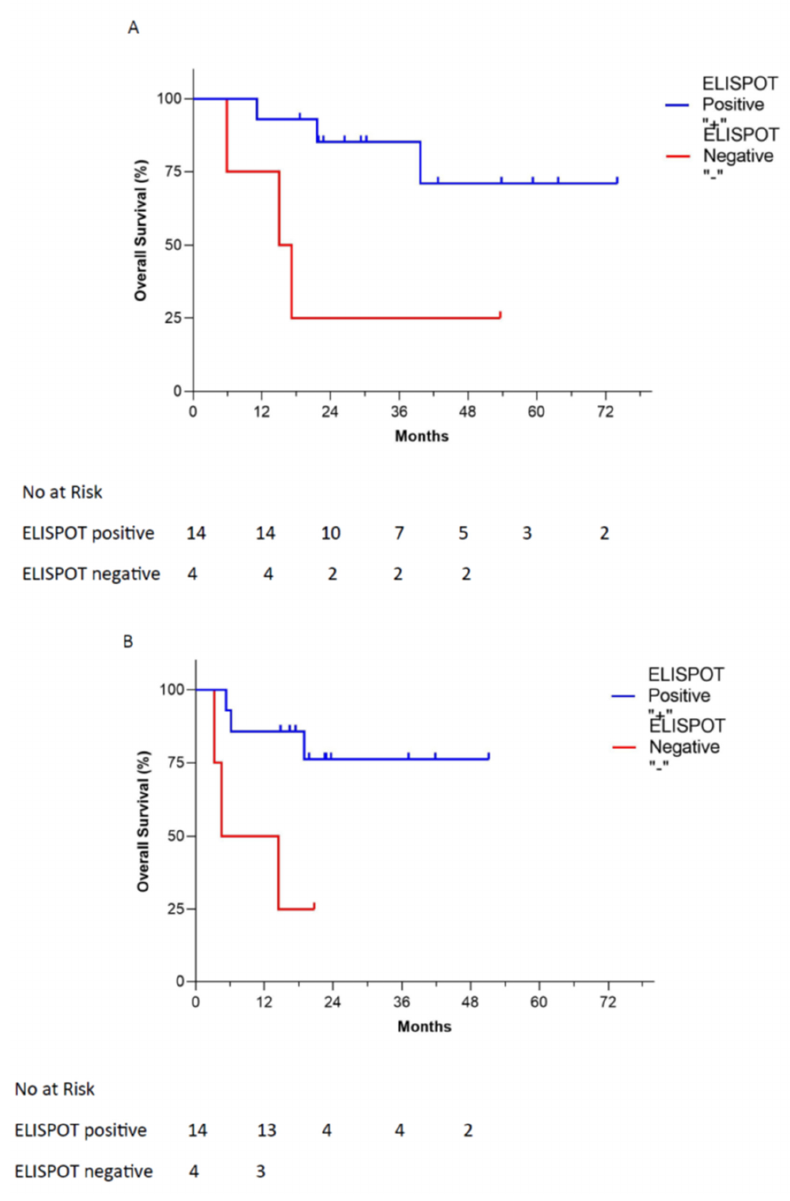
Figure 2. Overall survival relationship of Vigil treatment recurrent/refractory ovarian cancer patients by γ -IFN-ELISPOT-positive vs. γ -IFN-ELISPOT-negative recurrent ovarian cancer patients from time of tissue procurement ( A ) and start of treatment ( B ).